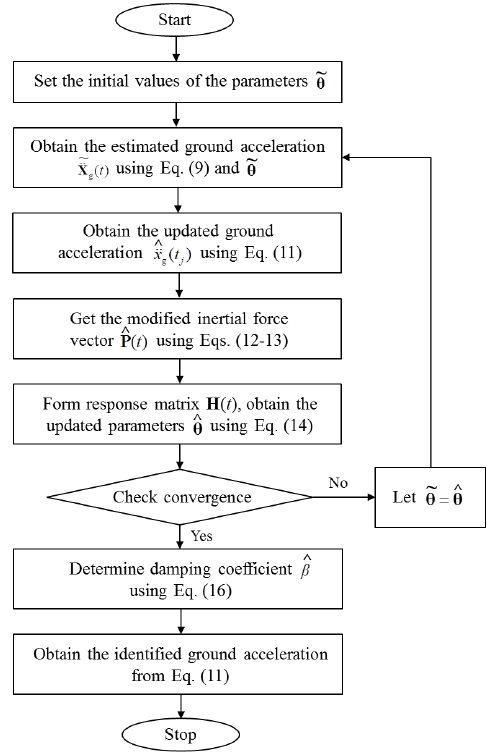
Figure 1. Flowchart of the proposed iterative identification procedure.